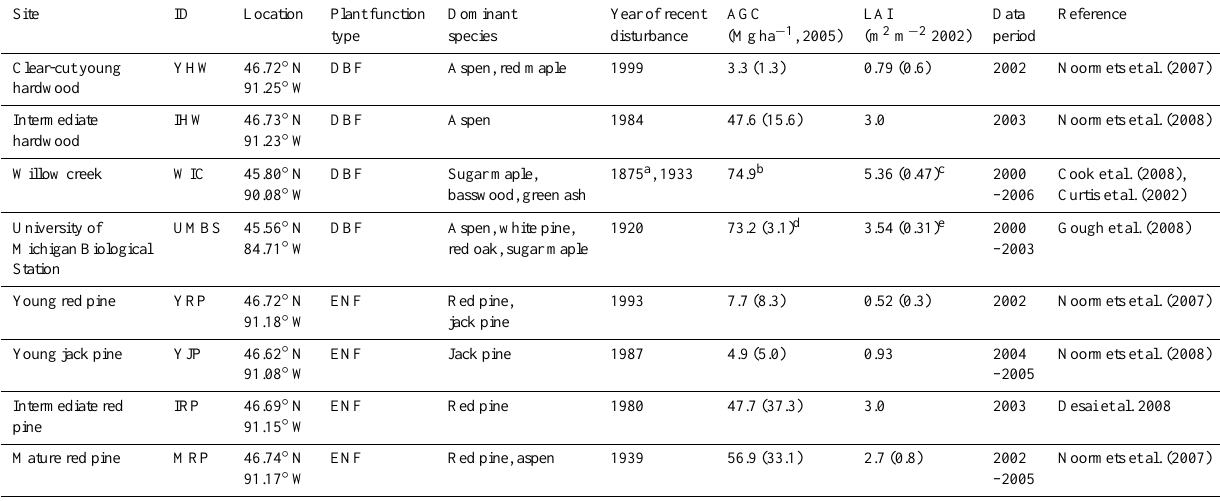
Table 1. Site characteristics for two chronosequences of deciduous broadleaf forests (DBF) and evergreen needleleaf forests (ENF) in the Upper Midwest region of Wisconsin and Michigan,